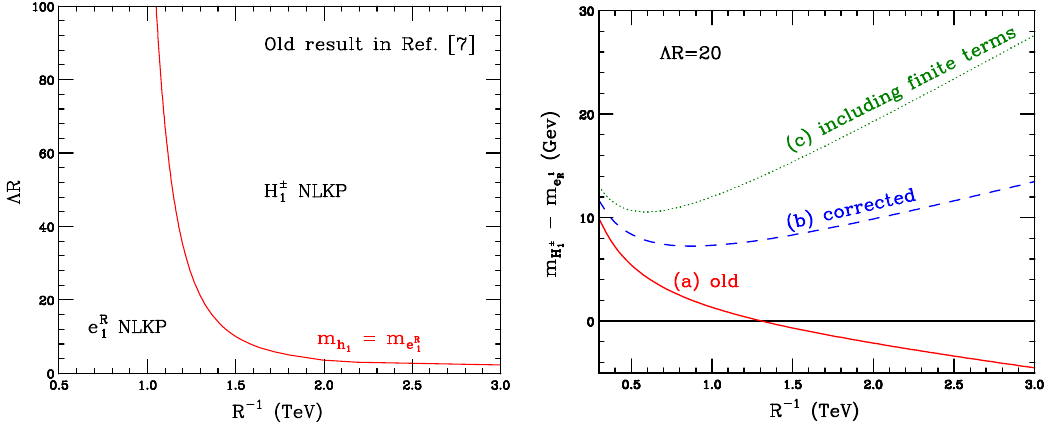
Figure 9 . Left: the phase diagram in the ( R (cid:0) 1 , (cid:3) R ) plane from ref. [15] is reproduced using the incorrect numerical factor (see text), which shows that the KK Higgs could be the NLKP in MUED for a large value of R (cid:0) 1 . Right: (cid:12)xing (cid:3) R = 20, the old (incorrect) result is shown in (red, solid) as a function of R (cid:0) 1 . The correct result is shown in (blue, dashed), while the curve in (green, dotted) includes (cid:12)nite terms. We (cid:12)nd that KK leptons are always the NLKP.